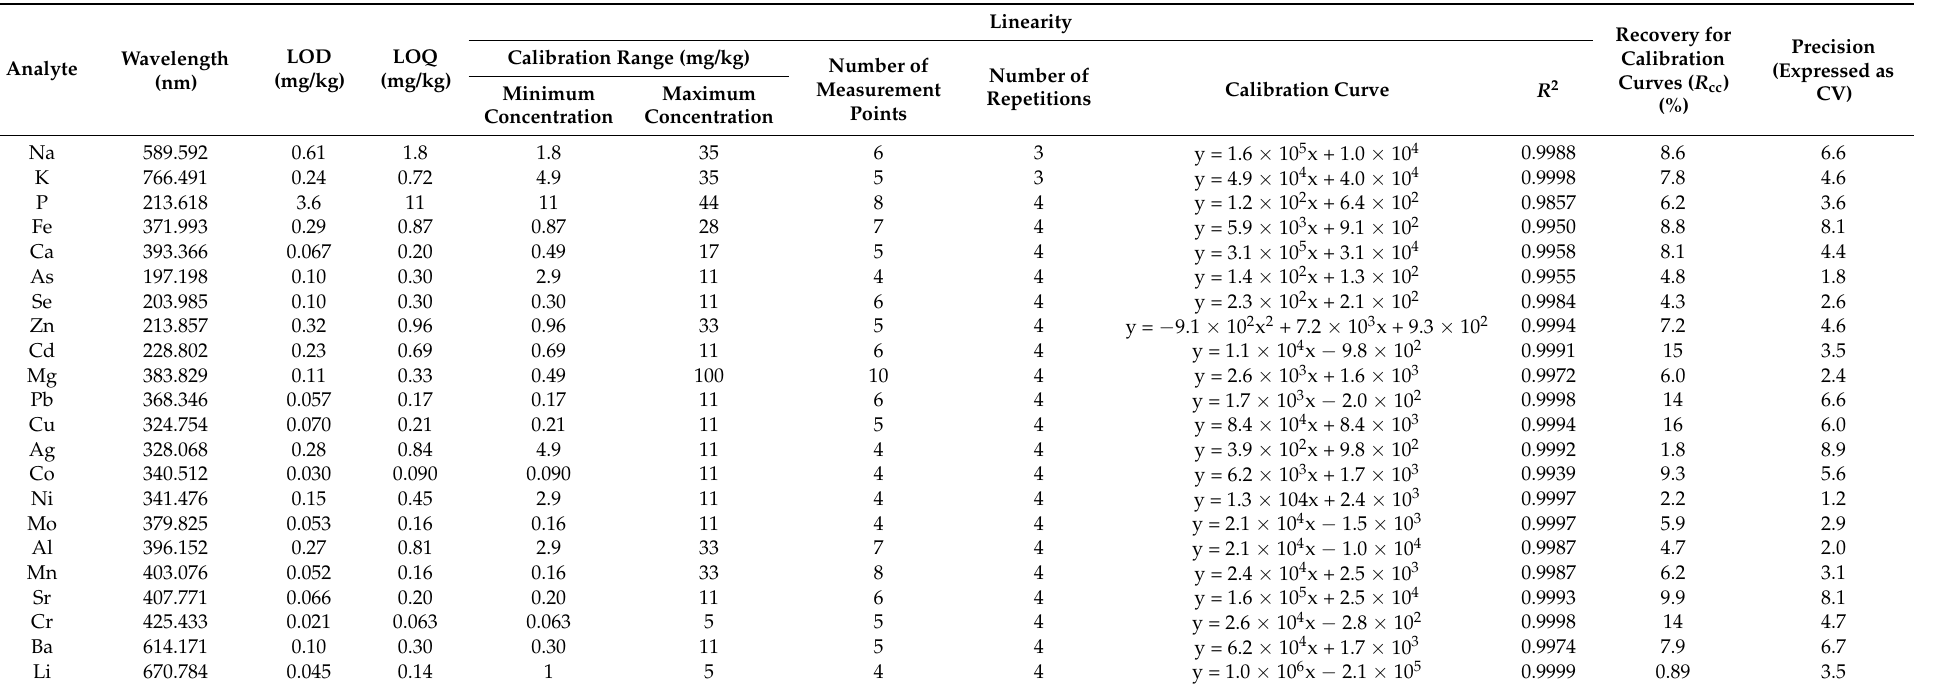
Table 3. Validation parameters of the procedure for the determination of selected elements in samples of beetroot and beetroot-based dietary